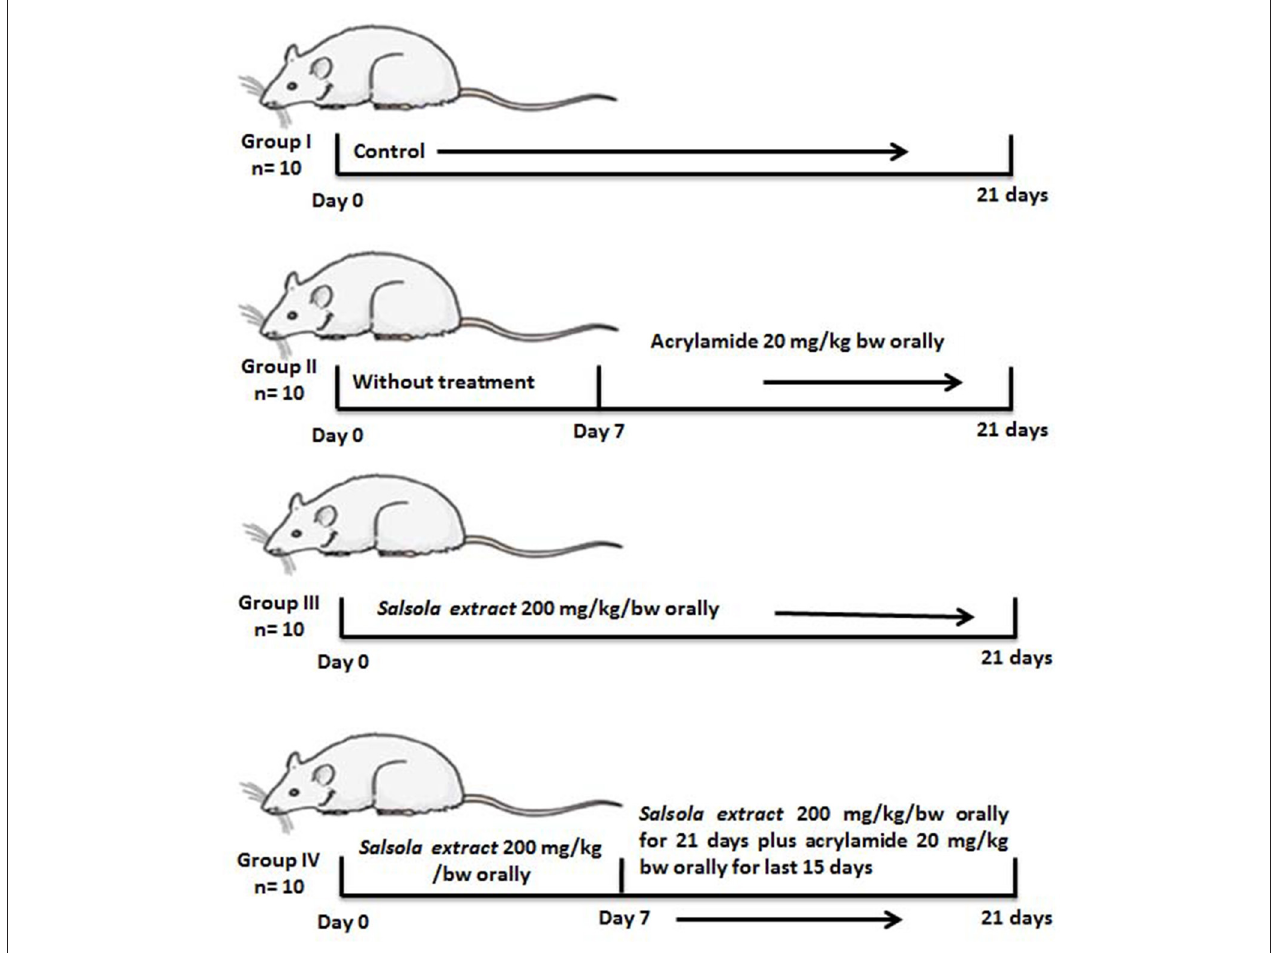
FIGURE 1 | A schematic diagram for the experimental design used in the current